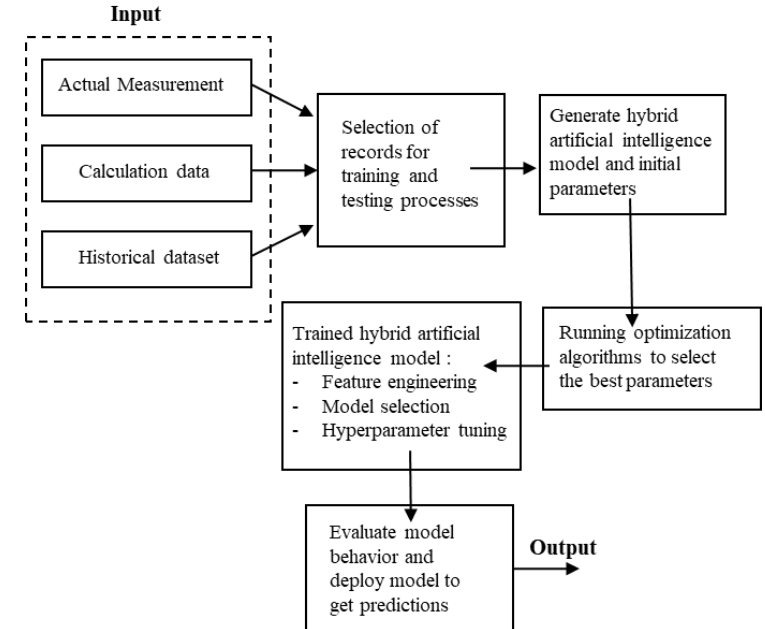
Figure 5. A general structure of the hybrid artificial intelligence model.